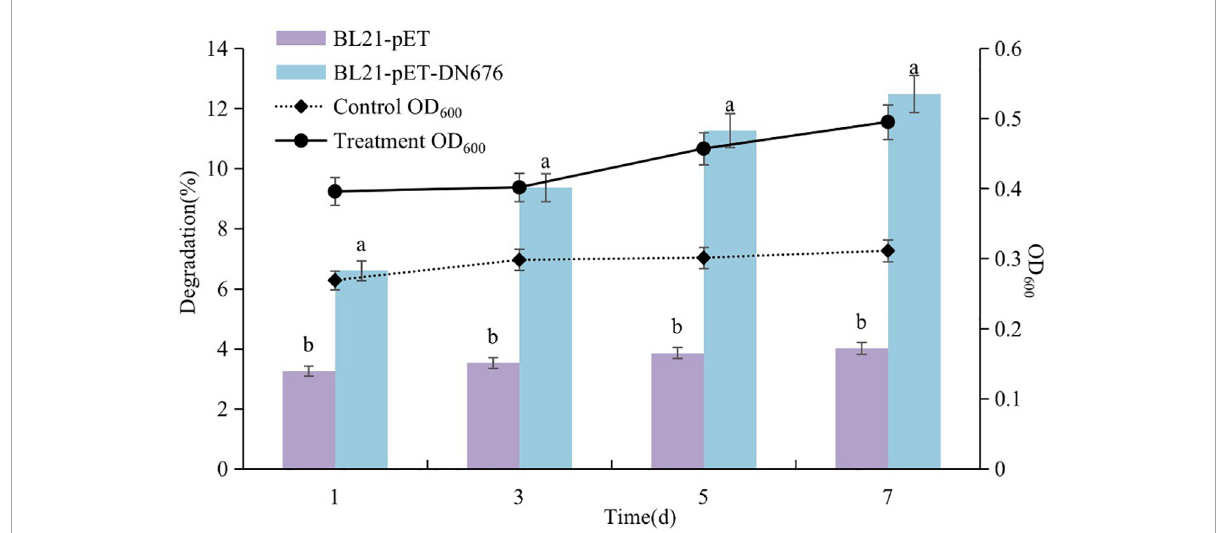
FIGURE8 Growth and Diquat degradation of BL21-pET and BL21-pET- DN676 strains. Error bars represent the standard deviation of three replicates. Different letters indicate significant differences between different treatments ( P <